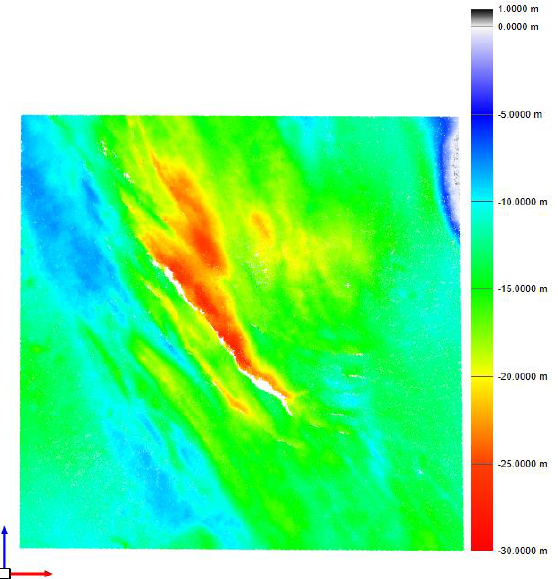
Figure 11. Height comparison map between 2014 DPC co- registered using ICPDPC method and 2016 DPC: focus on